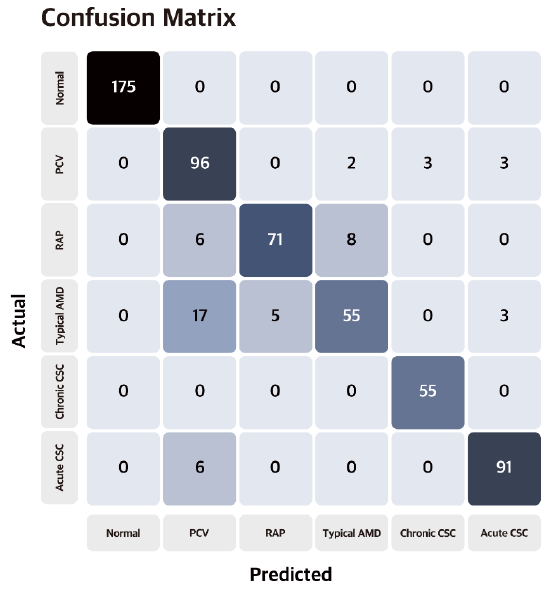
Figure 3. Confusion matrix of the proposed model. The vertical axis is the ground truth, and the horizontal axis is the model prediction. Our proposed model recorded 91.1% classification accuracy for the test set.